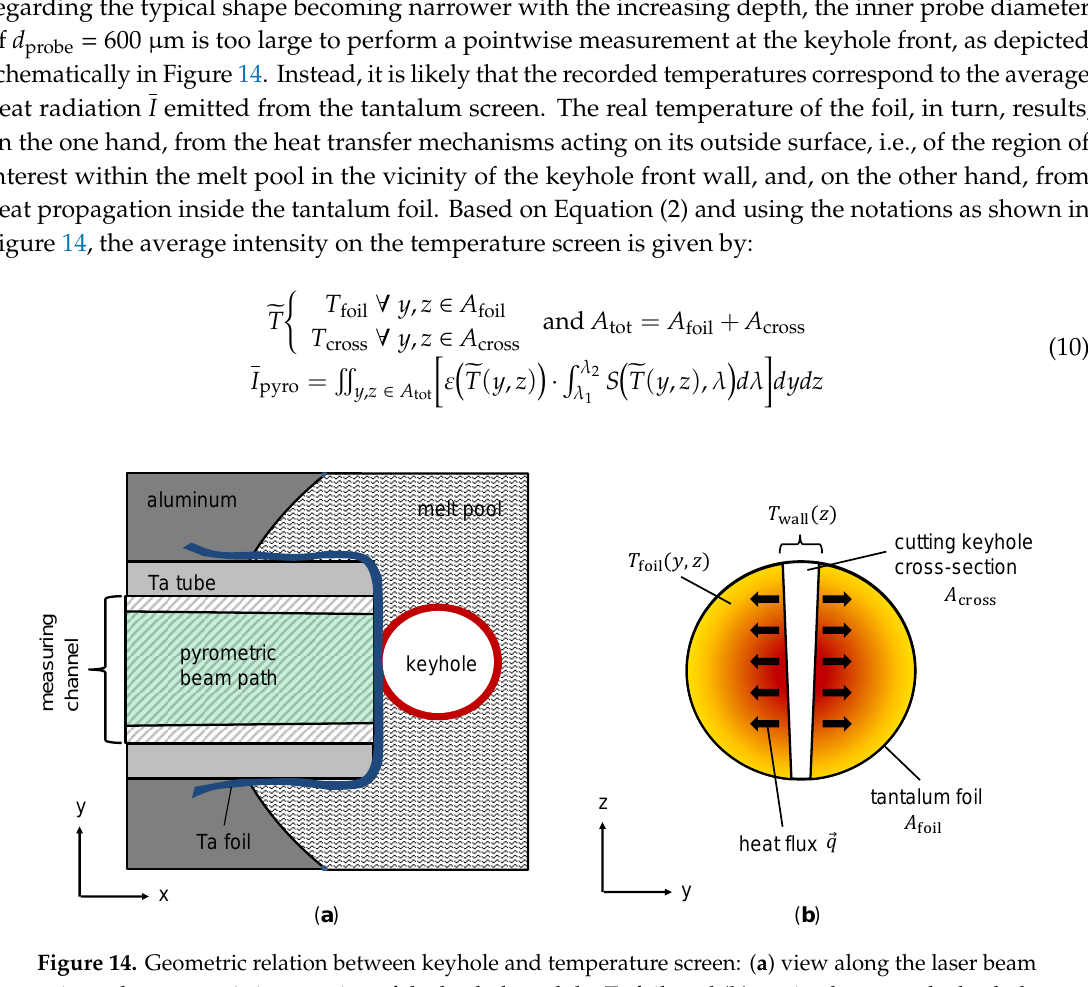
Figure 13. Comparative temperature curves of two independent measurements with the same process parameters.